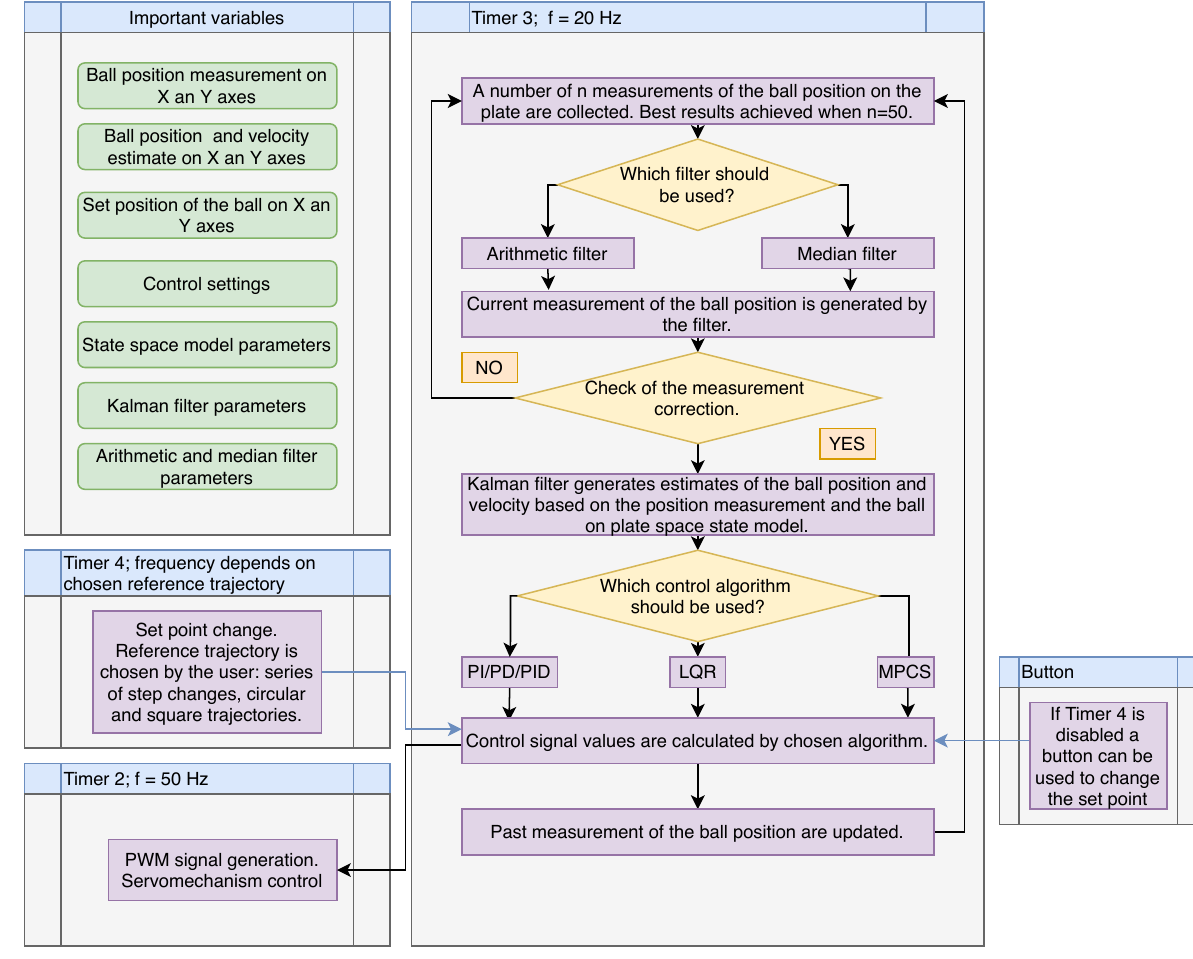
Figure 2. The structure of the real-time software